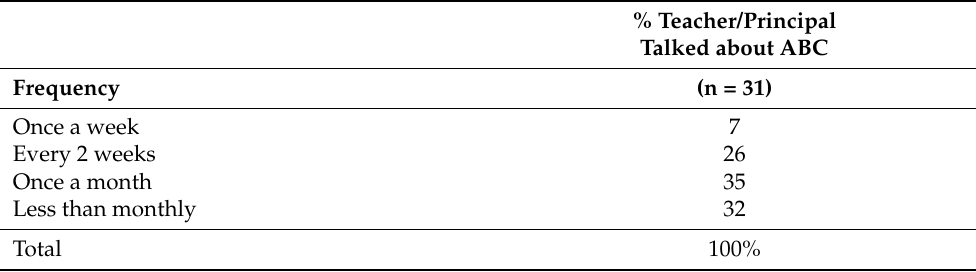
Table 5. Follow-up respondents’ reporting of how often they saw/heard about Act–Belong–Commit at their